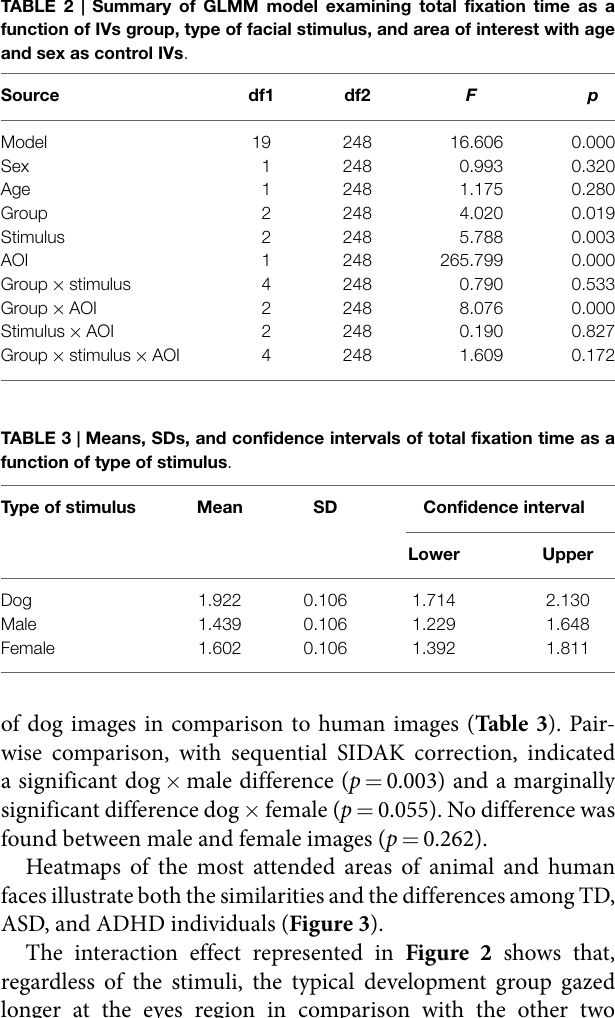
FIGURE 2 | Total fixation time as a function of type of stimulus .